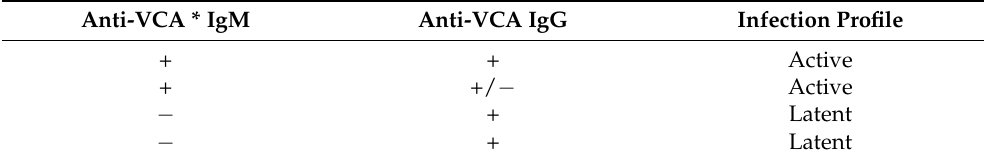
Table 1. Laboratory criteria for classifying the EBV infection